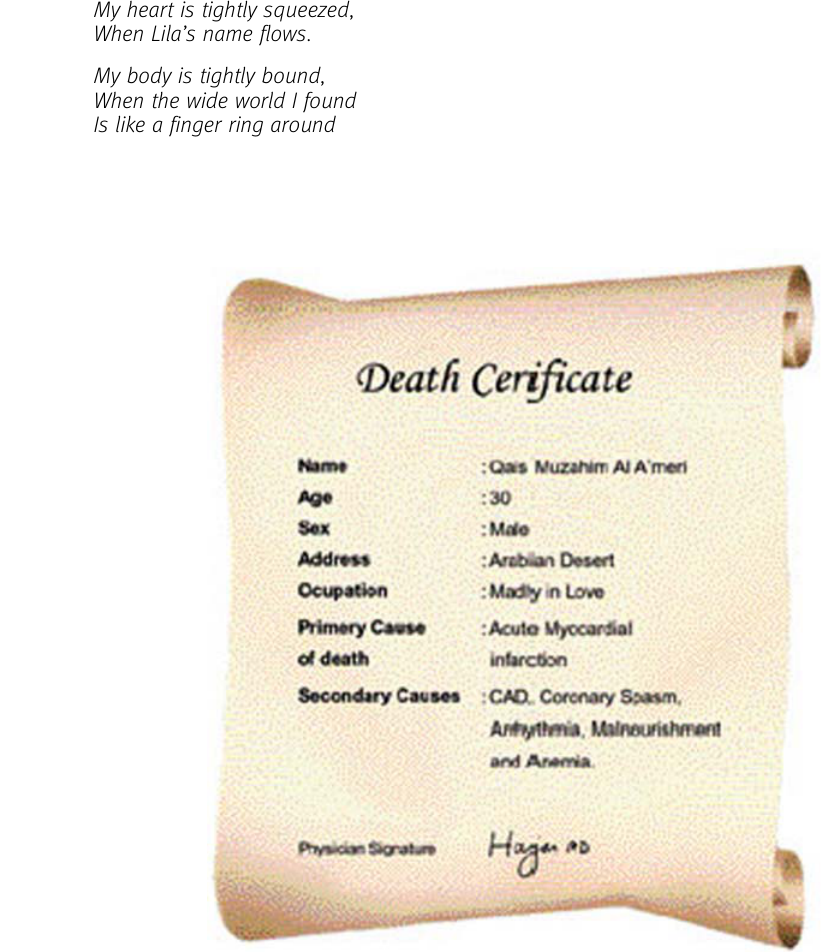
Figure 1. Based on the above information, I had to issue a death certificate for